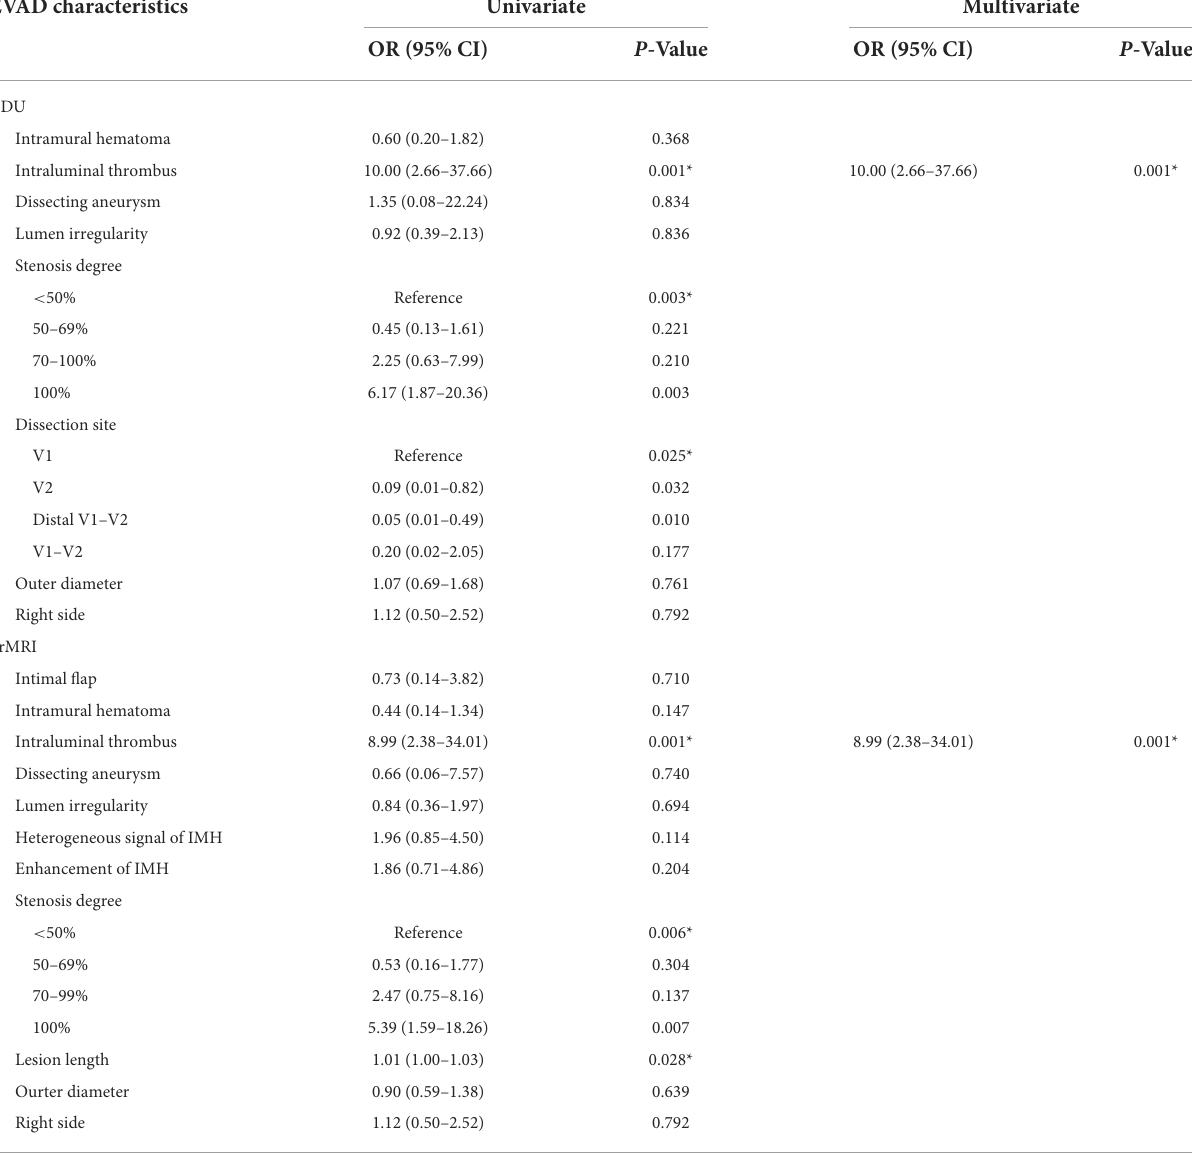
TABLE 4 Characteristics of EVAD on CDU and hrMRI correlated to ischemic